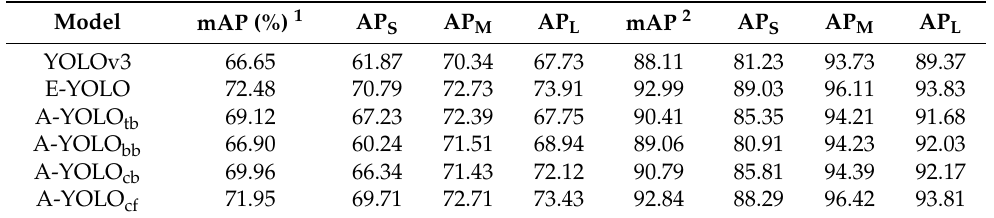
Table 1. The average precision of visual detectors on LVSH and UA-DETRAC. We split the original test set into the small-scale set, the medium-scale set, and the large-scale set for a fair comparison of different models on multi-scale inference. For example, AP S refers to the average precision on the small-scale set.